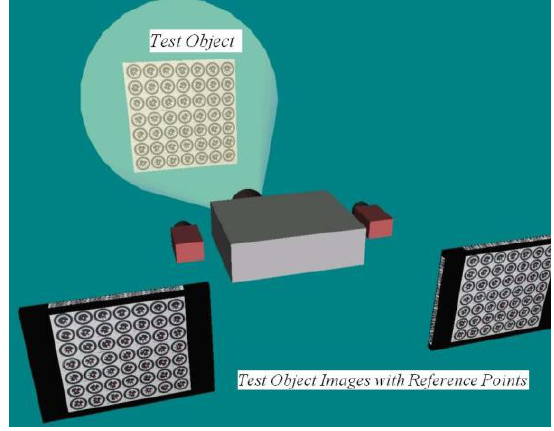
Figure 3. Stereo system calibration